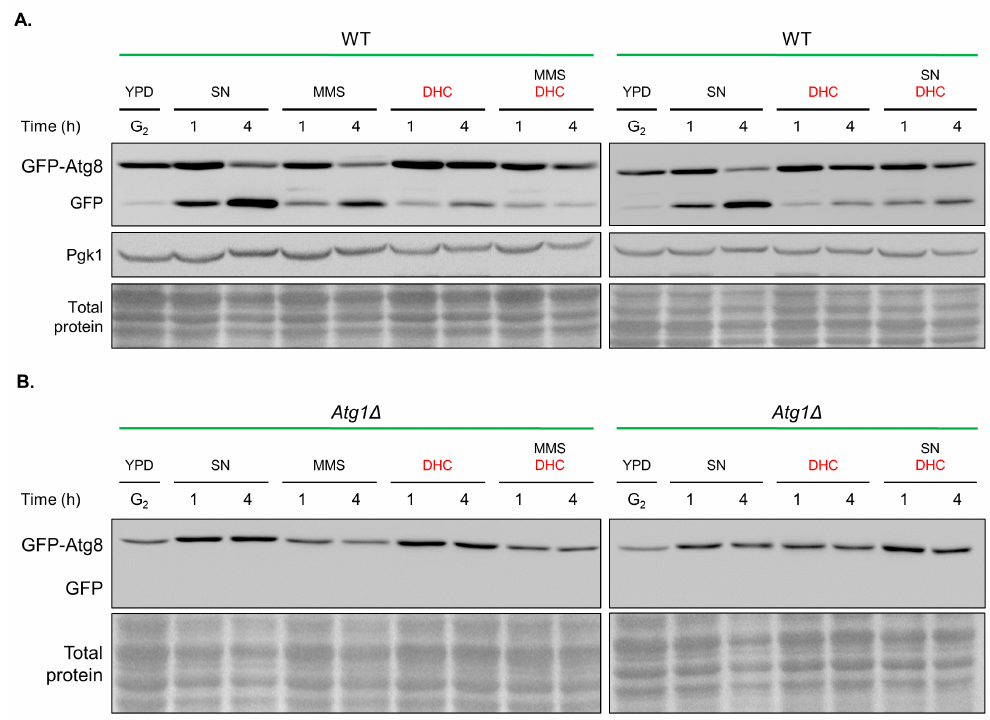
Figure 9. DHC inhibits autophagy in response to DNA damage. ( A ) GFP-Atg8 (RLY004) cells and GFP-Atg8 atg1 ∆ (RLY005) cells were cultured in YPD, nitrogen starvation (SN) conditions, MMS (0.1%), DHC (5 mM), SN + DHC and MMS + DHC for 4 h. Samples were processed for Western blot using GFP antibodies. The Pgk1 protein level and total protein, as assessed through amido black staining, served as loading controls; ( B ) GFP-Atg8 atg1 ∆ (RLY005) cells served as a negative control.